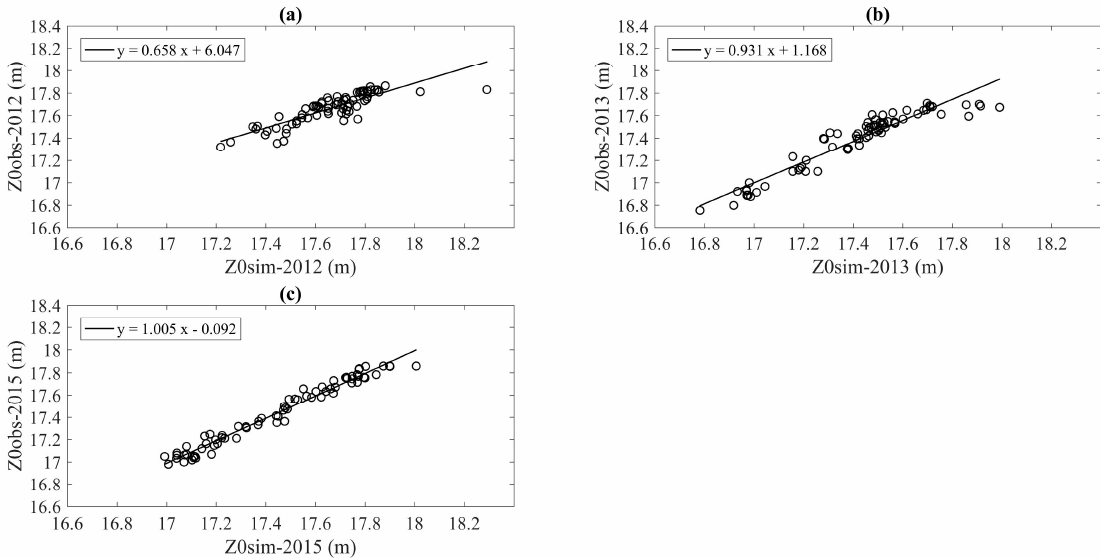
Figure 14. The linear interpolation of Z 0 obs and Z 0 sim for the optimized model for the years 2012 ( a ), 2013 ( b ) and 2015 ( c ).